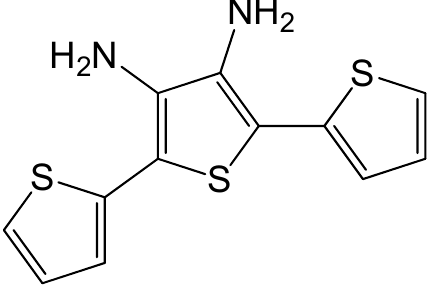
Figure 3. Structure of diamine functionalized terthiophene monomer [2,2 ′ :5 ′ ,2 ″ -terthiophene]-3 ′ ,4 ′ - diamine (DAT).